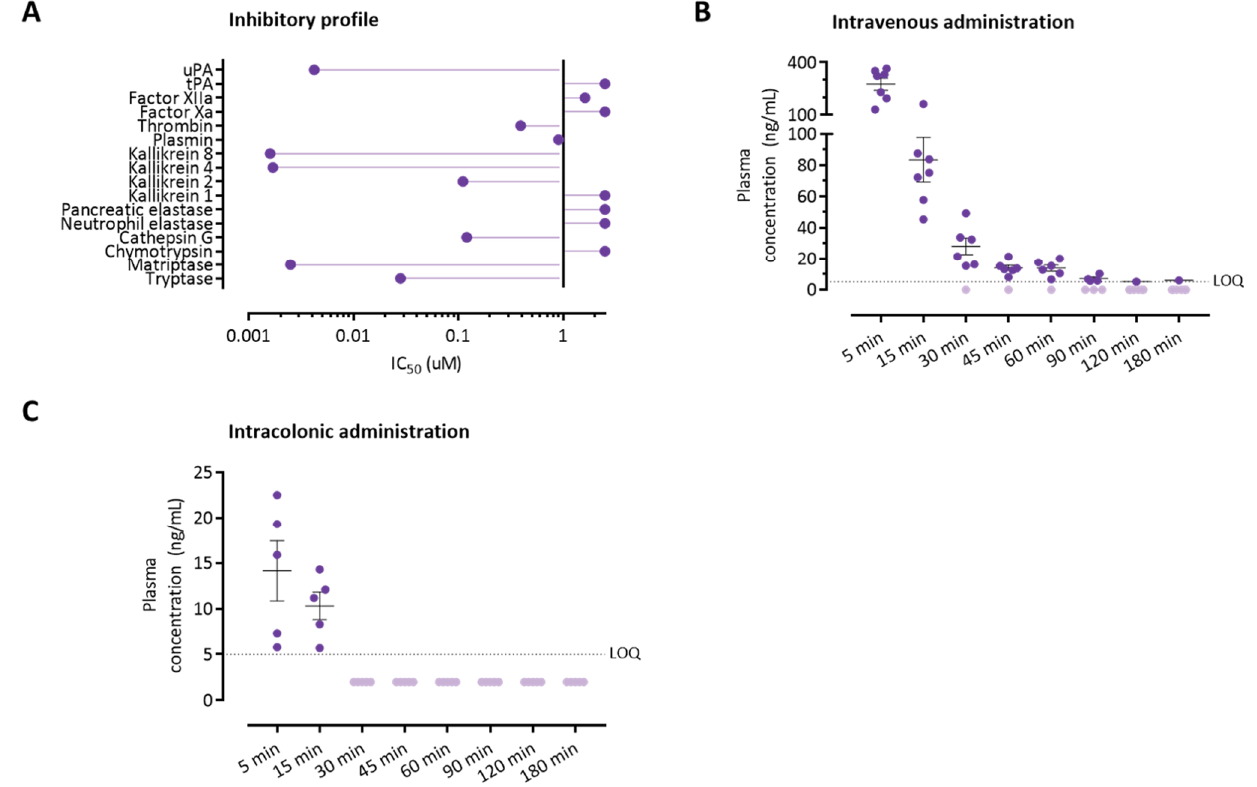
Figure 5. Pharmacokinetic properties of UAMC-00050. ( A ) Inhibitory profile of UAMC-00050 for a selection of proteases. IC 50 > 2.5 µM, indicating non-efficient inhibition of the enzyme by UAMC-00050, are visualized as IC 50 = 2.5 µM to allow for easier interpretation of the data. IC 50 values were, in part, reproduced from Ceuleers and colleagues, with permission of the authors [16]. ( B ) Plasma concentrations after intravenous administration of UAMC-00050 (1 mg/kg), longitudinally collected, n = 7. Data are presented including means ± SEM. ( C ) Plasma concentrations after intracolonic administration of UAMC-00050 (5 mg/kg), longitudinally collected, n = 5. Data are presented including means ± SEM. LOQ, lower limit of quantification.